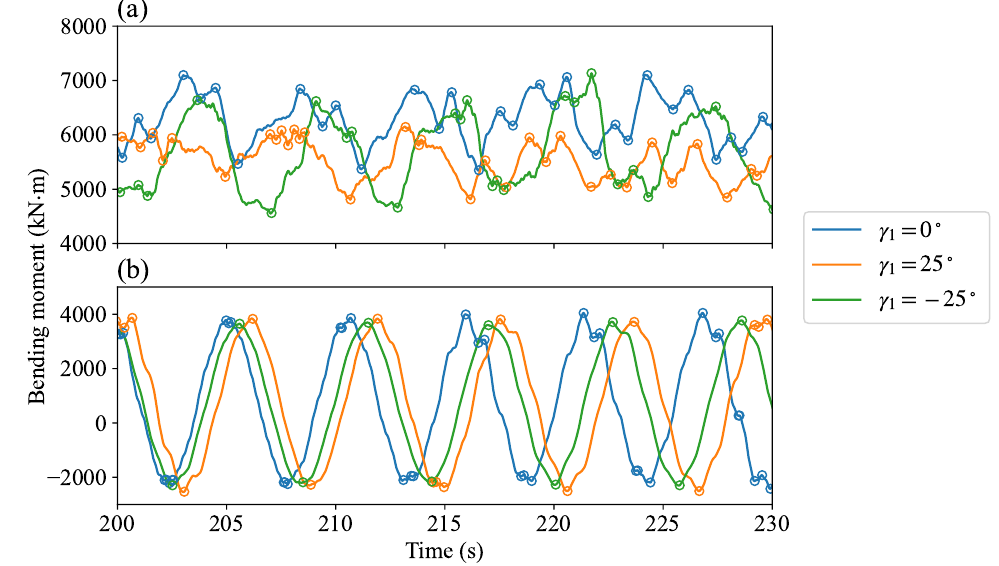
Figure 8. Time series segments of blade-root bending moments of WT 1: ( a ) flapwise bending moment and ( b ) edgewise bending moment. Empty cycles show the load reversal points extracted by the rainflow counting